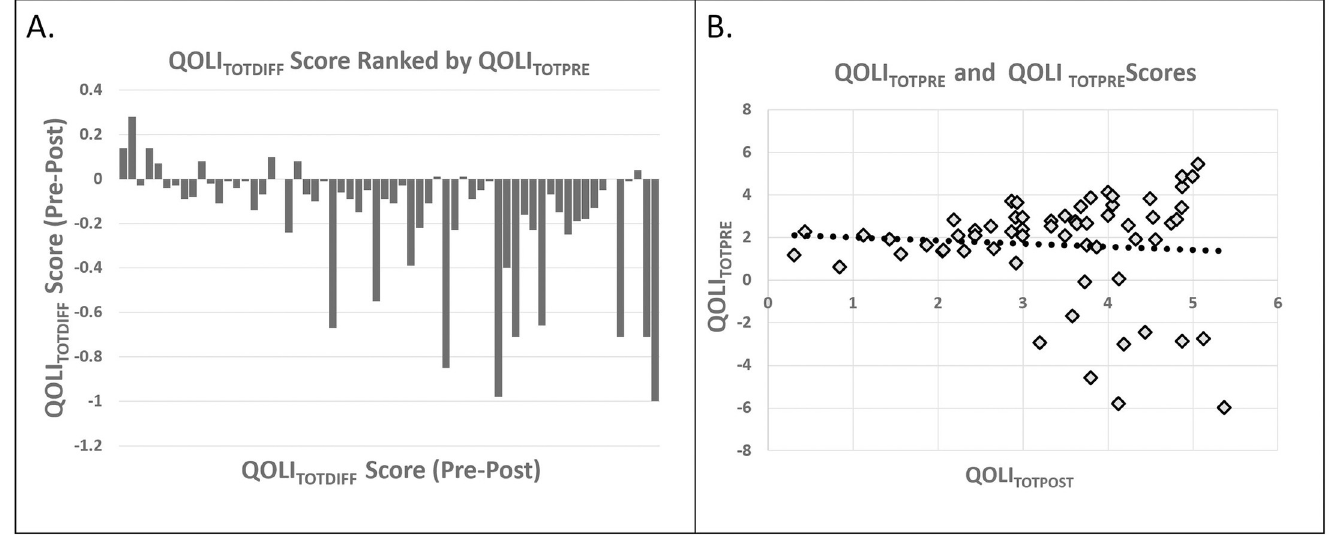
Fig 3. ( A ) Rank-order plot showing change in quality of life scores as they relate to quality of life ratings going into social isolation. Participants with higher quality of life scores at the beginning of social isolation (right side of graph) showed greater isolation-induced decreases in quality of life. QOLI TOTPRE = pre-isolation quality of life scores; QOLI TOTDIFF = post-isolation quality of life scores = pre-isolation quality of life scores. ( B ) Correlation between QOLI TOTPRE and QOLI TOTPOST .